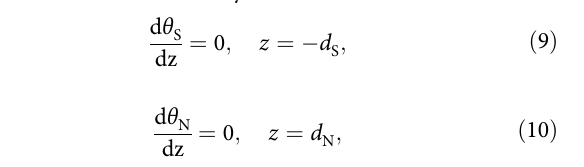
Matsubara frequencies, ξ N = coef fi cient in N, k = ξ N / ξ S , Q is the circular component of the vector potential Q = (0, Q , 0) normalized to Φ 0 / 2 πξ S . The pair potential Δ in (2) – (5) is normalized to π k B T c , and the coordinates r , z are normalized to ξ S . The physical meaning of ξ N is discussed at the end of the paper.